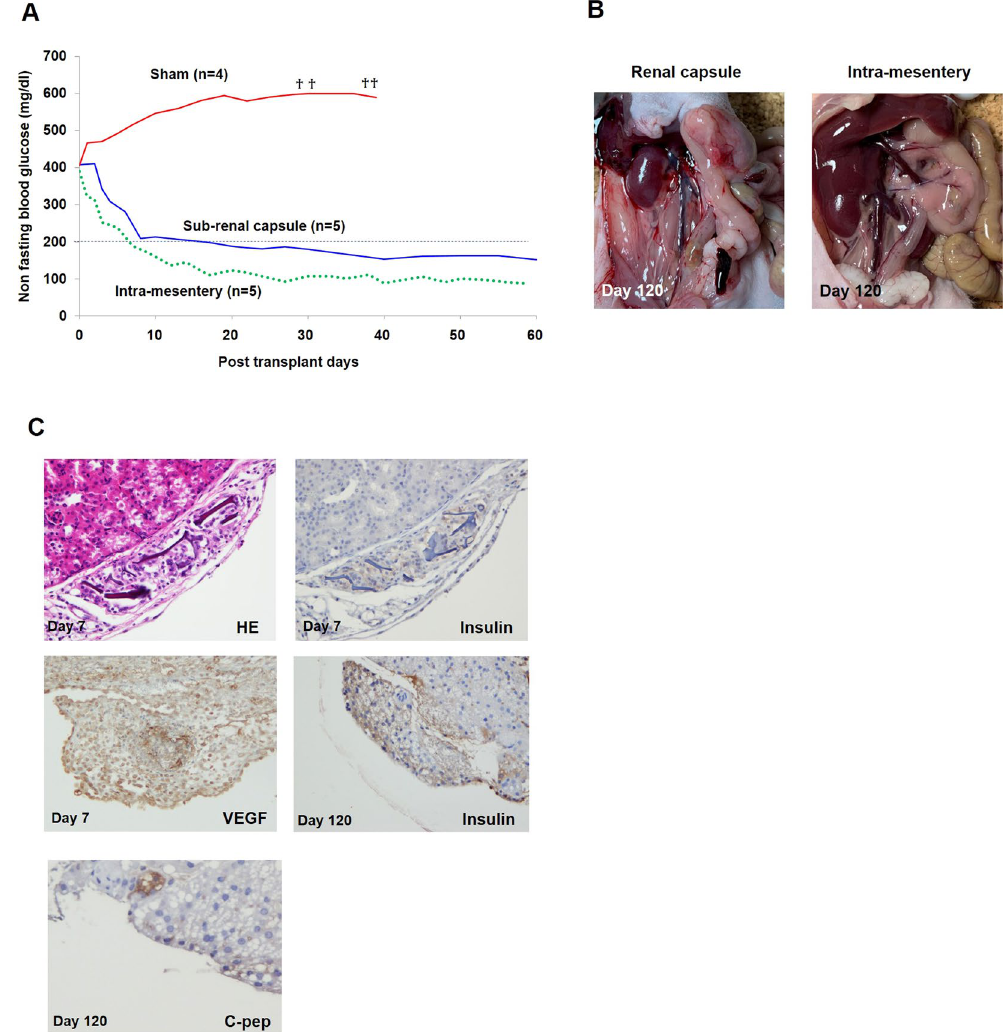
Figure 5. In vivo study. (A) Non-fasting blood glucose levels were decreased gradually after transplantation and measured below 200 mg/dl around 14 post-transplant days and maintained up to 60 post-transplant days in sub-renal capsule group (n = 5) and intra-mesentery group (n = 5). †: death. (B) No abnormal tumor formation was observed in each transplanted site at 120 post-transplant days. Left: around IPC transplanted right kidney, Right: mesentery. (C ) Upper left. Transplanted CellSaic under kidney capsule at day 7. Central necrosis was not observed. Haematoxylin-eosin staining. Original magnification, × 400. Upper right. Continuous section of upper left was stained by anti-insulin antibody. Cytoplasm of IPC in CellSaic was strongly stained for insulin. Original magnification, × 400. Middle left. Transplanted IPCs at day 7 also showed strong expression of VEGF. Original magnification, × 400. Middle right. Transplanted CellSaic under kidney capsule at day 120. Central necrosis was hardly observed. Cytoplasm of IPC in CellSaic was strongly stained for insulin. RCP pieces were vanished, considered to have been absorbed. Original magnification, × 400. Lower. Some parts of this structure were strongly stained by C-peptide. Original magnification, ×